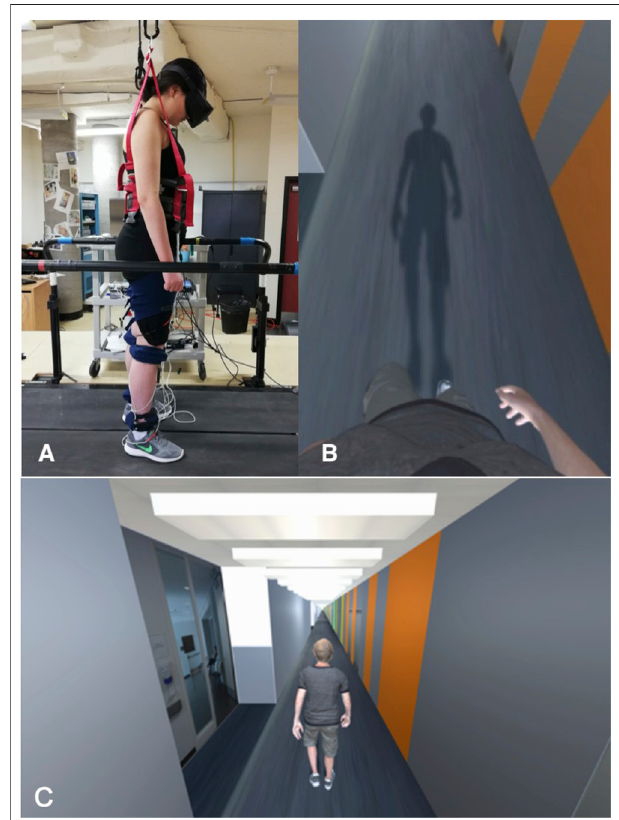
FIGURE 1 | Experimental set-up, with head-mounted display, vibrators strapped on the ankles, knees, and hips, and security harness (A) ; the visual scene displayed in the head-mounted display from a 1 PP (B) ; the virtual environment shown from a 3 PP (C)